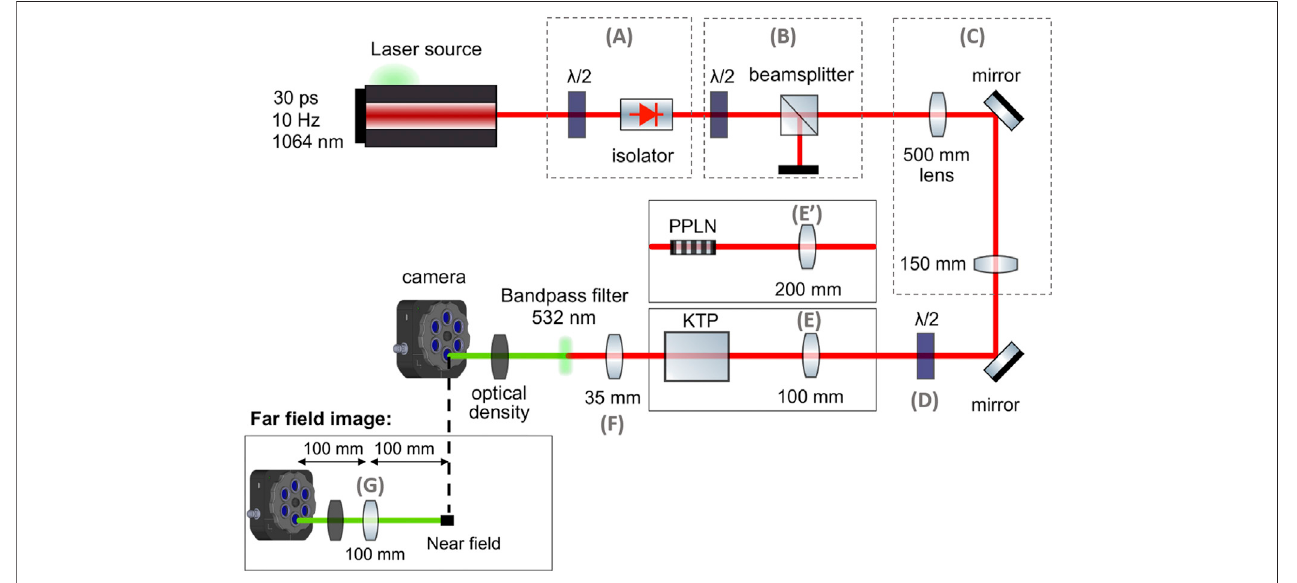
FIGURE 1 | Schematic of the experimental